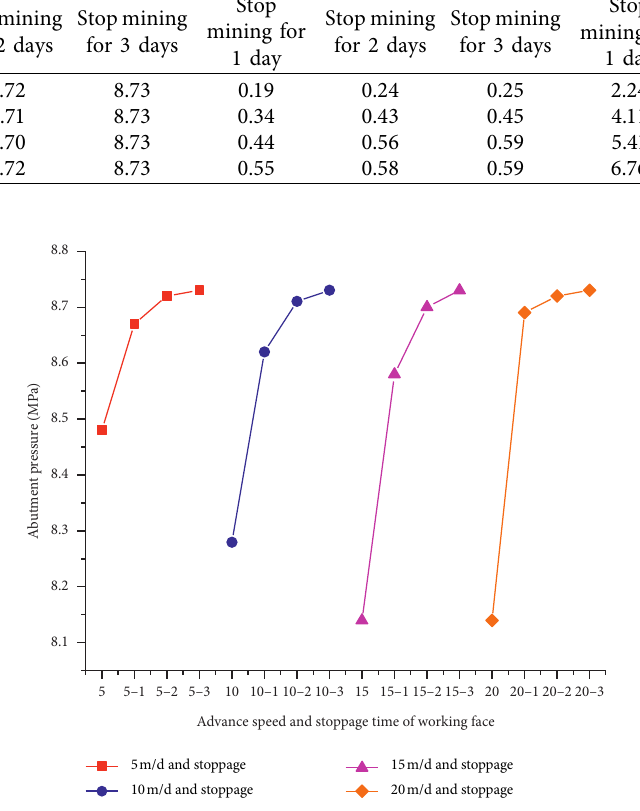
Figure 7: Maximum characteristic value changes for different rates of advance.